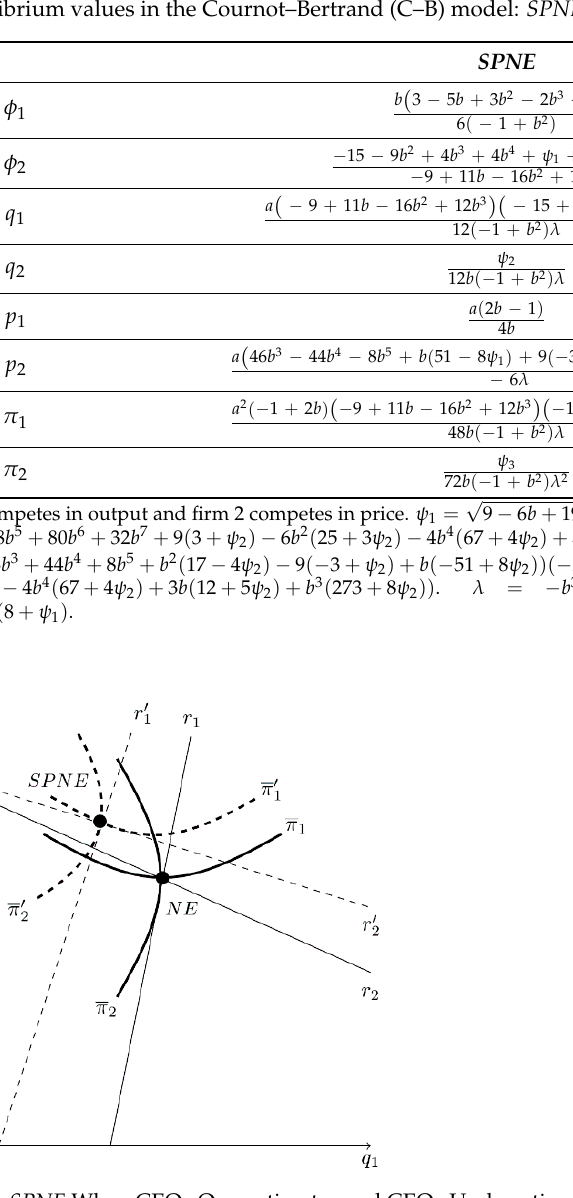
Figure 15. The SPNE When CEO 1 Overestimates and CEO 2 Underestimates Product Substitutability in the Cournot ‐ Bertrand Model.